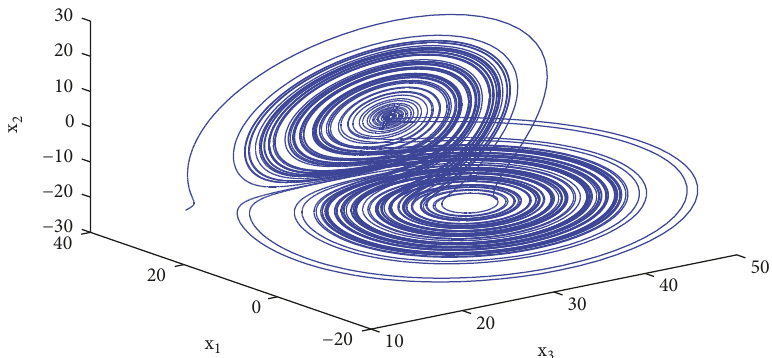
Figure 1: The chaotic trajectories of system (35) with 𝛼 = 0.995, 𝑑(𝑡) = 0,𝜃 = 2 and 𝑥 1 (0) = 4,𝑥 2 (0) = −3,𝑥 3 (0) = 2